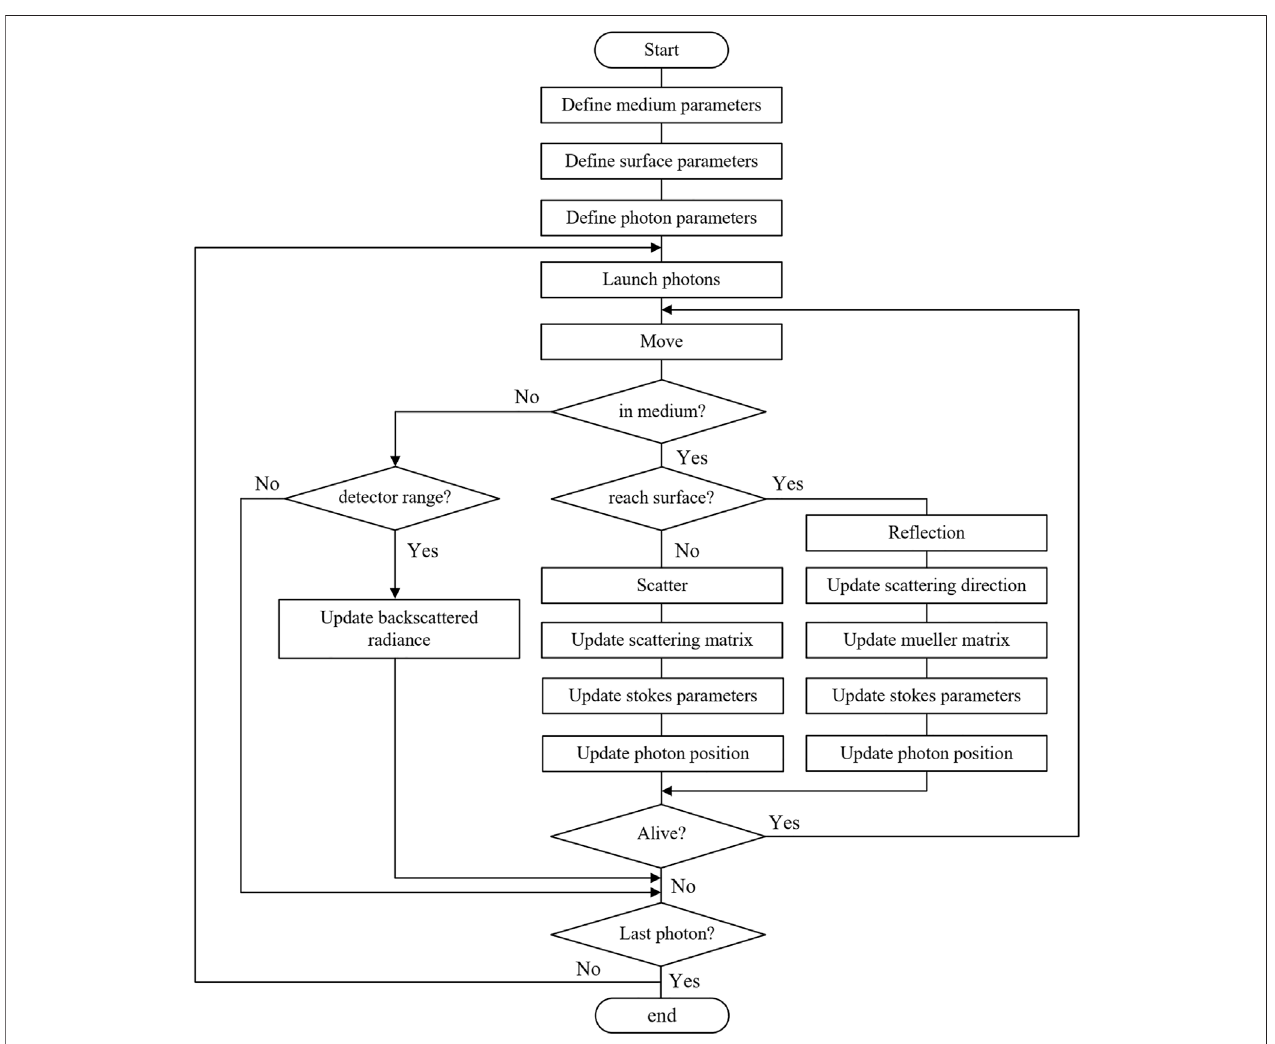
FIGURE 1 | The fl ow chart of simulation